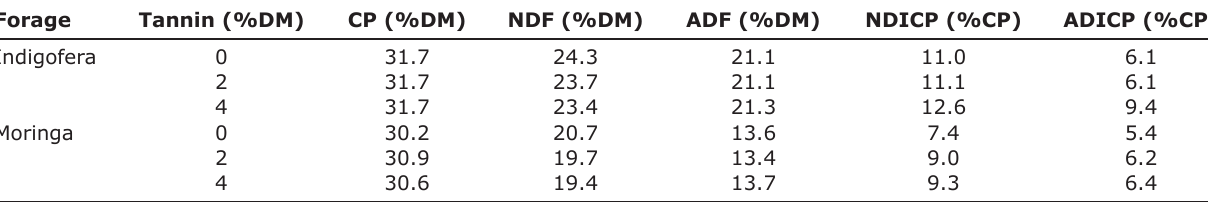
Table-1: Chemical composition of Indigofera and Moringa leaf silage with different level of chestnut tannin addition. Forage Tannin (%DM) Indigofera